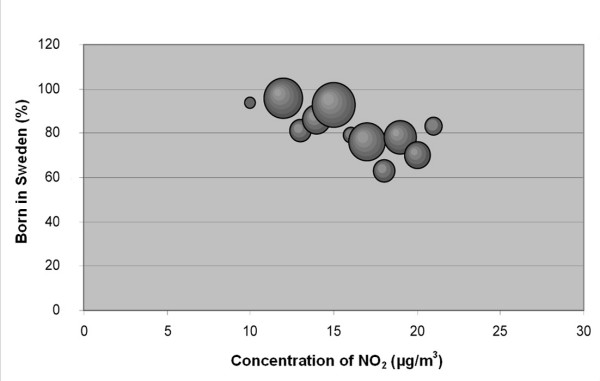
Bubble diagram for Malmö; Percentage of population in Malmö born in Sweden versus annual mean concentration of NO2 at their real estate. The bubbles are sized according to the weight of the estimate, which depends on the size of the population that the estimate is based on. The weight is thus a measure of the uncertainty in the estimate, and large bubbles represent more certain and influential estimates than small bubbles.